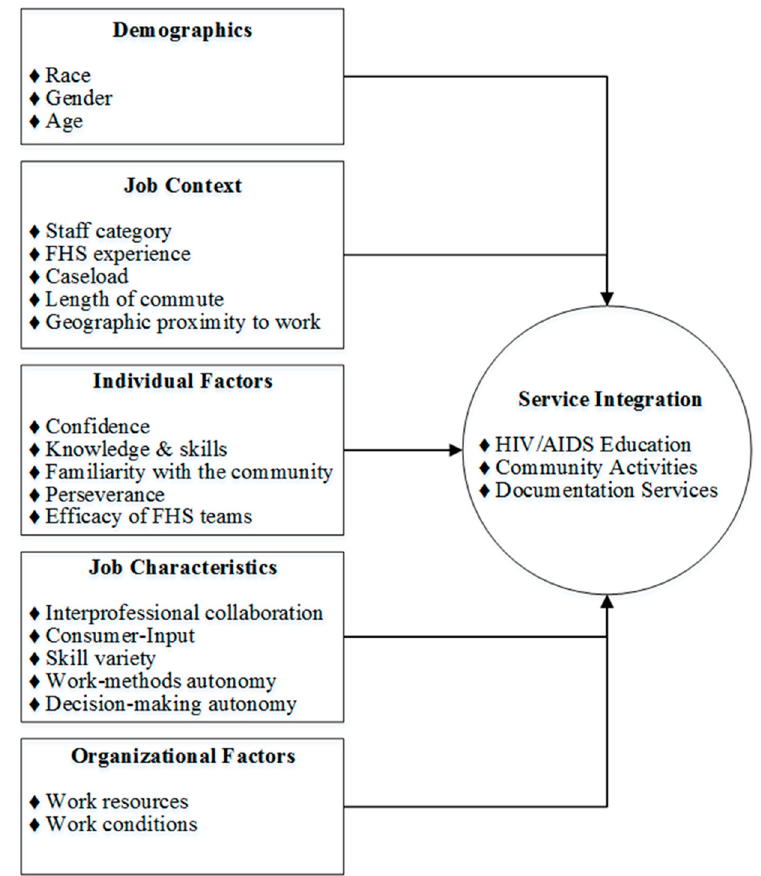
Figure 1. Service Integration Framework. FHS: Estratégia Saúde da Família (Family Health Strategy); Human Immunodeficiency Virus Infection and Acquired Immune Deficiency Syndrome (HIV/AIDS).